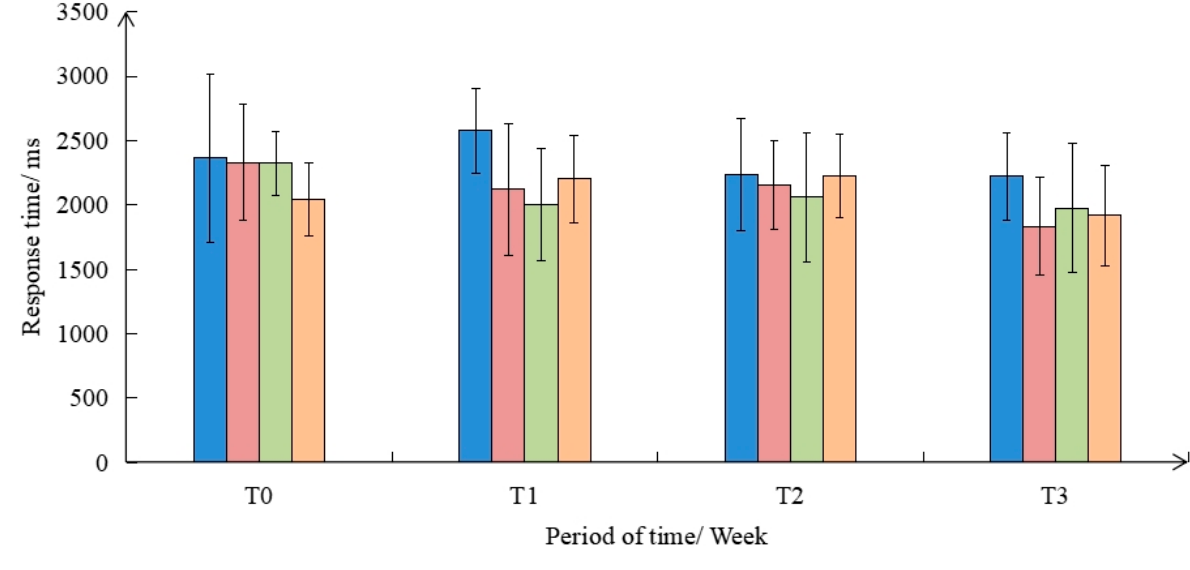
Figure 4. Changes in the accuracy of different groups and time periods.